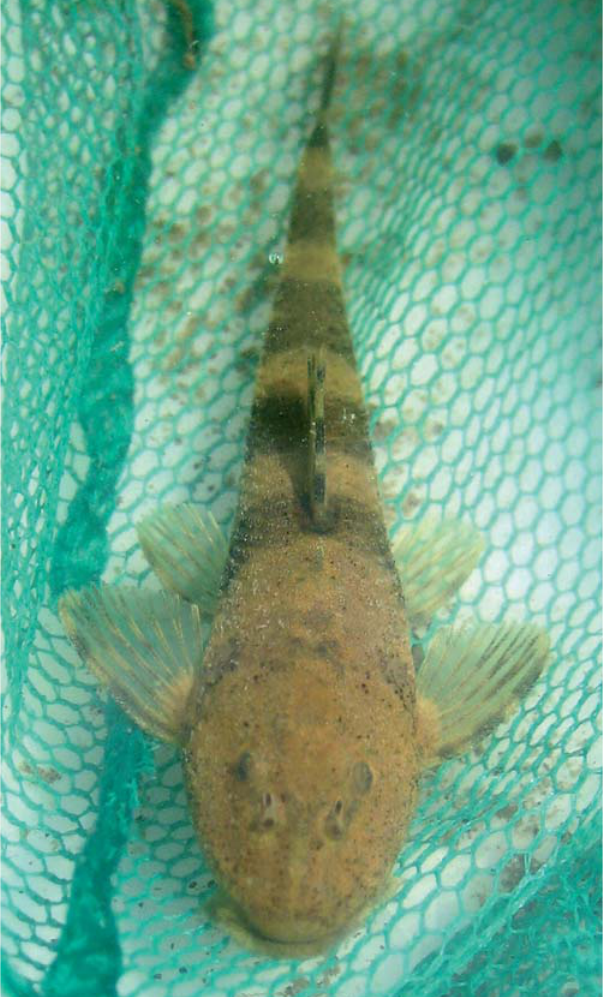
Fig. 8. Living specimen of Ixinandria steinbachi from the río Arenales near Salta, Argentina, November 2007. Photo by